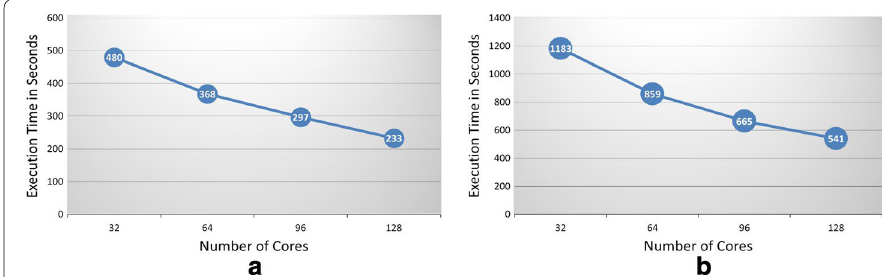
Fig. 10 Execution time for StreamAligner to map ( a ) ANL and ( b ) ERR000589 datasets on Chr1